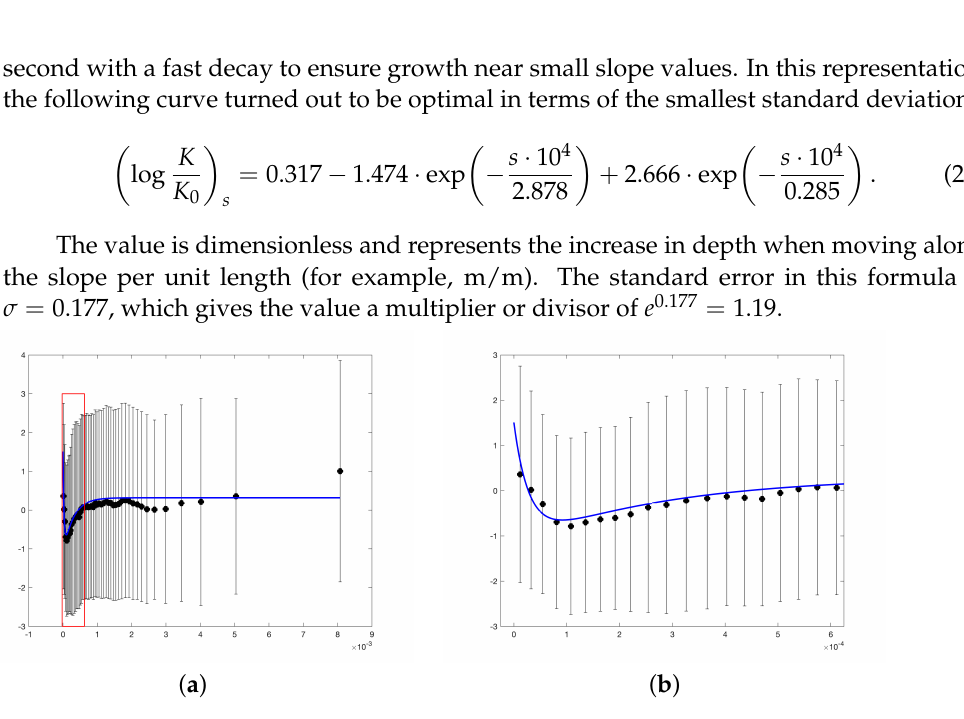
Figure 7. Same as Figure 5, but depending on the slope of the bottom s ( a , b ). − ¯ q The dependence of the characteristic tanh q in representation (18) turned out to be σ ( q ) not so pronounced. The mean value and standard deviation in cluster A for the counter- gradient flux turned out to be ¯ q = − 0.0467 kg/(m 2 · s) and σ ( q ) = 473 kg/(m 2 · s). The